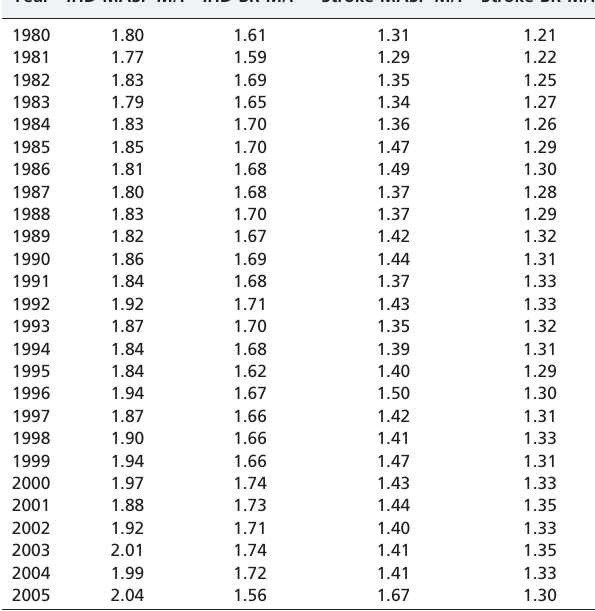
Table 2 - Ischemic heart disease (IHD) and stroke ratios in women (w) and men (m) $ 30 years of age in Brazil (BR) and in the metropolitan region of Sa˜o Paulo (MASP) from 1980 to 2005.